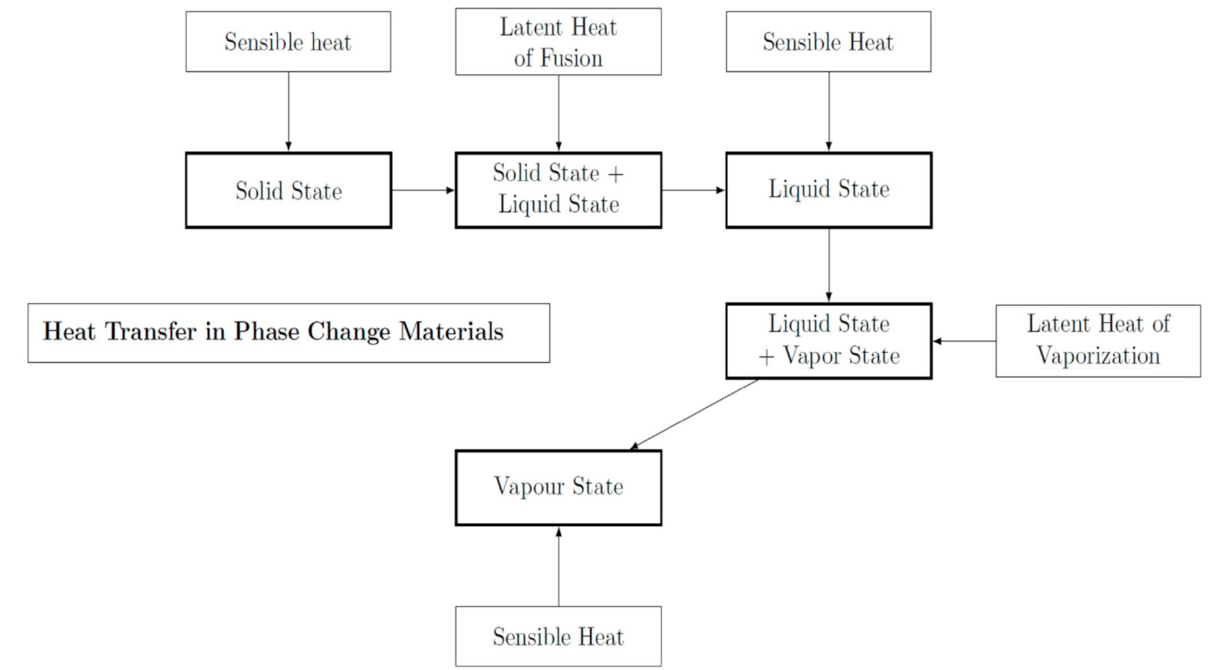
Figure 1. Diagram of heat transfer and PCM absorption states.